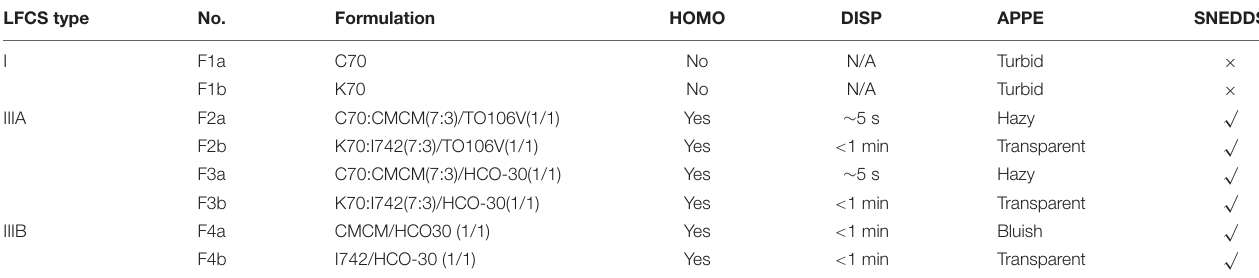
TABLE 3 | Visual assessment data of dispersions formed by various formulation systems (“group a” and “group b”) under conditions of self-emulsification. LFCS